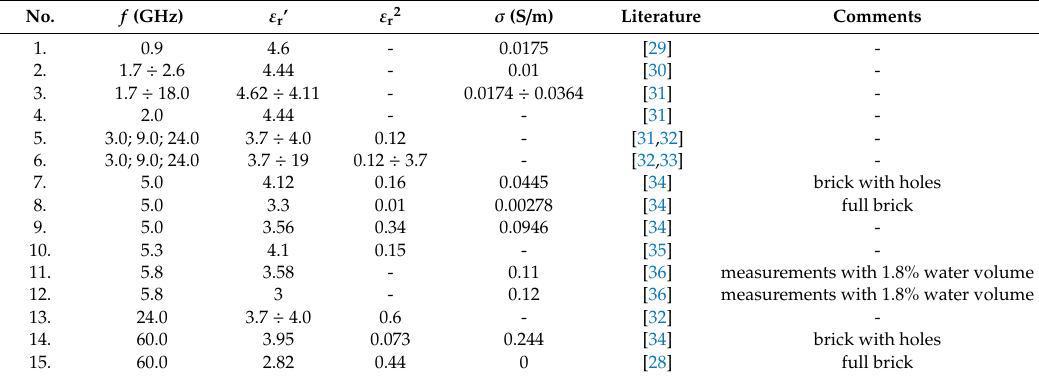
Table 2. Di ff erent electrical properties used for characterization of the